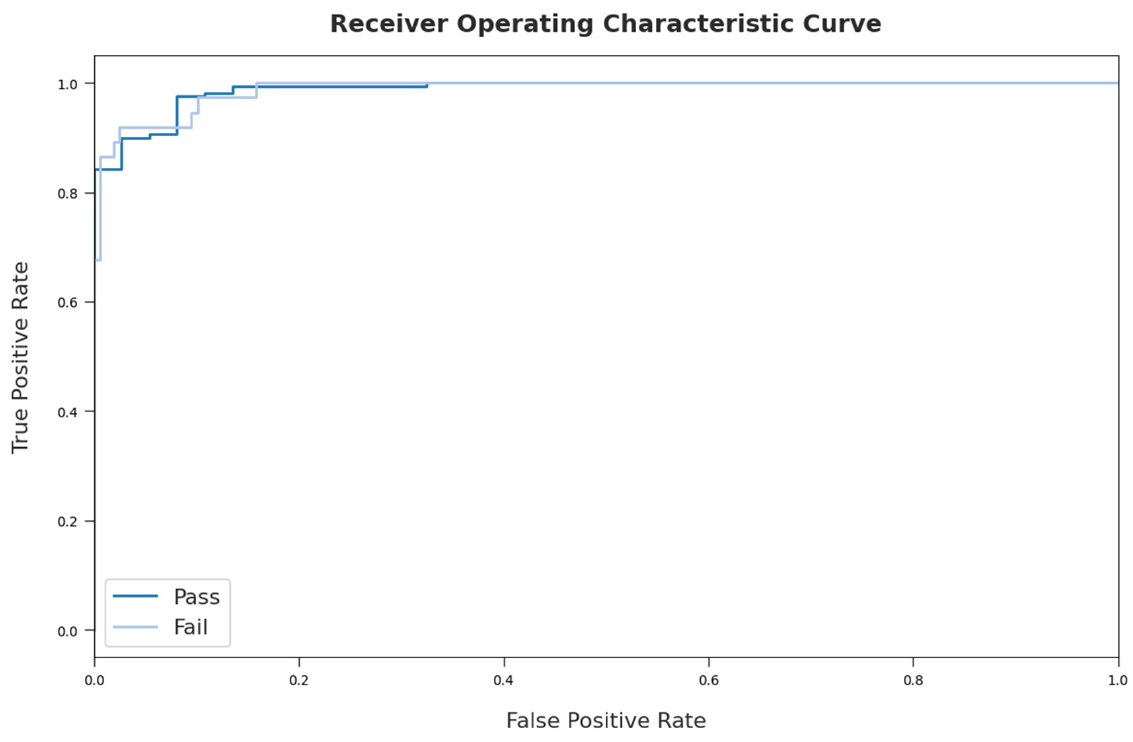
Figure 10. ROC curve analysis of FSSML-EDM technique.